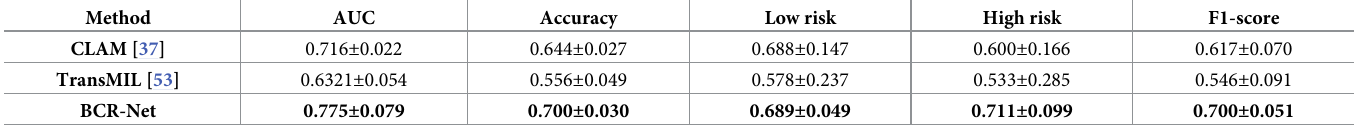
Table 2. Slide-level hold-out testing results on H&E-stained slides. K = 5000 for BCR-Net results. Values are reported with mean ± standard deviation across the five folds.